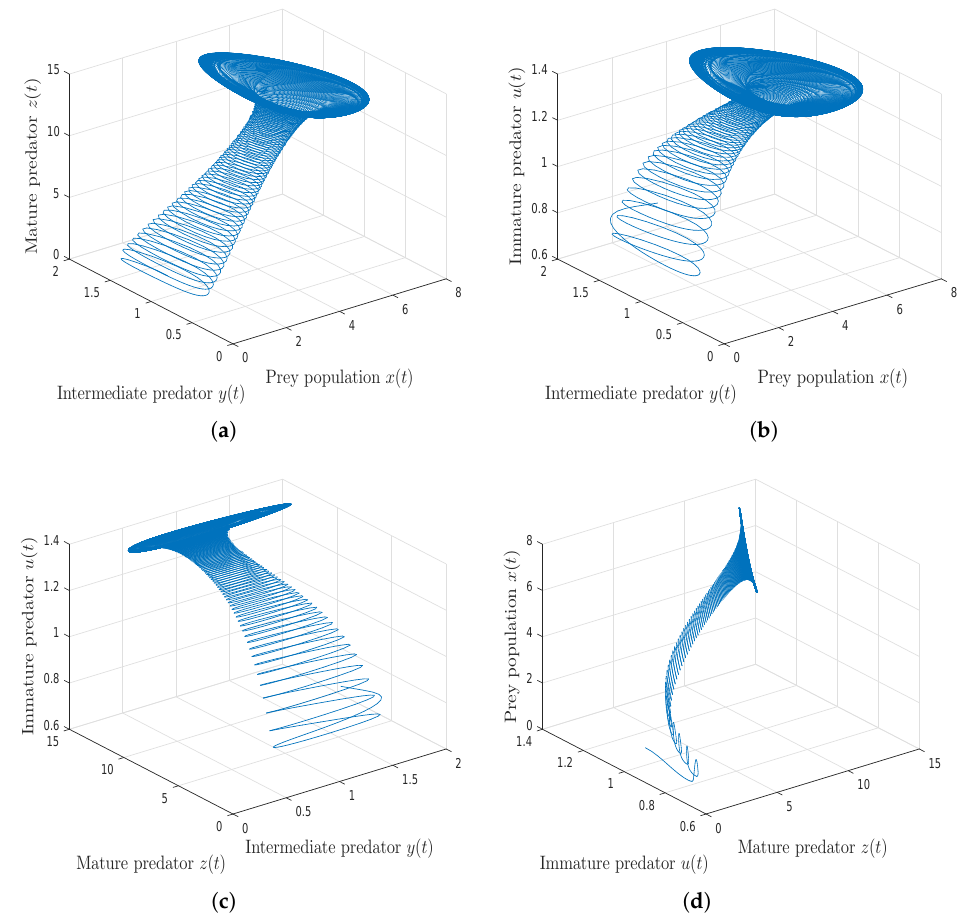
Figure 4. Three-dimensional chaotic phase plot for food web mathematical System (13) with general- ized Caputo fractional operator when ϕ = 1 and ρ =